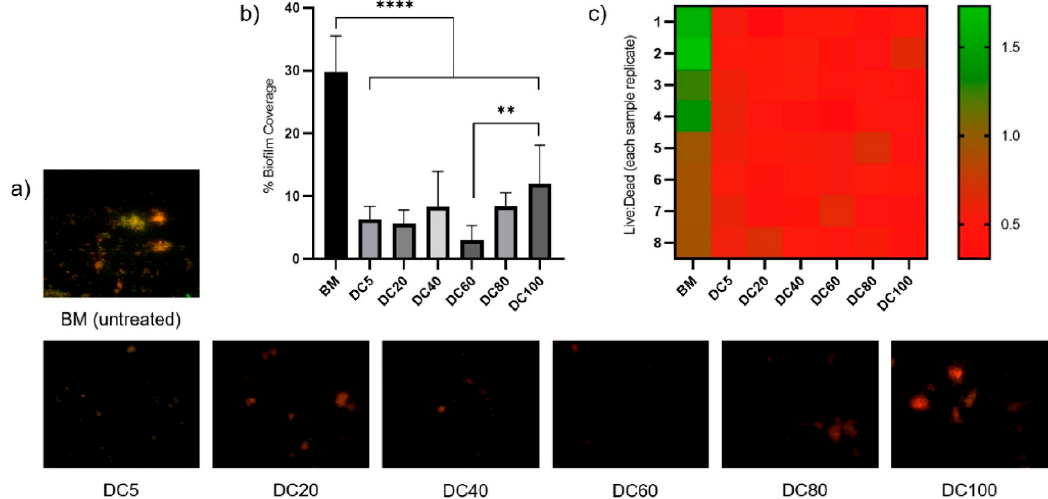
Figure 6. Bacterial coverage results for the untreated and laser-nitrided surfaces after 24h culture with S. aureus. ( a ) Representative images showing bacterial adherence/biofilm coverage on each sample. Images were obtained by live/dead staining and fluorescence microscopy. Live (viable) bacteria are stained green, and dead (non-viable bacteria) stained red. ( b ) Percentage biofilm coverage on each treated sample and untreated sample as determined by image analysis (* denotes significant difference, **: p < 0.01. ****: p < 0.0001). ( c ) Ratio of live: dead bacteria on each image analyzed for each sample and untreated sample control and data displayed as a heat-map. The scale shows samples with a greater proportion of live bacteria represented in green and greater proportion of dead bacteria represented in red. Reproduced with permission from [103], copyright Elsevier, 2020.